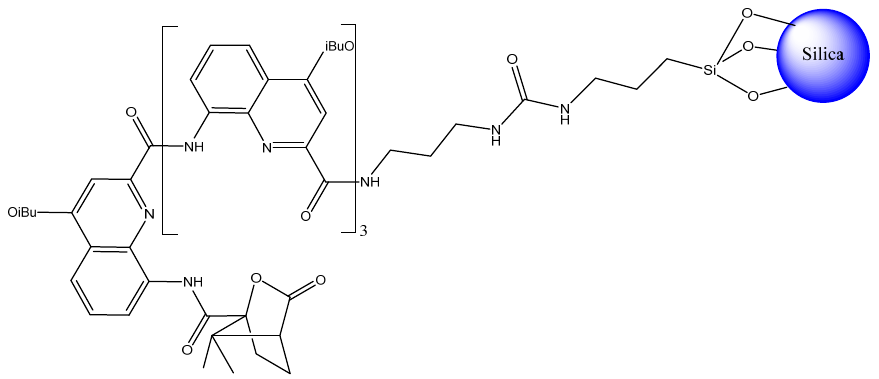
Figure 4. Chiral stationary phase comprising a P -helical quinoline oligoamide foldamer immobilized using an isocyanate derivative.